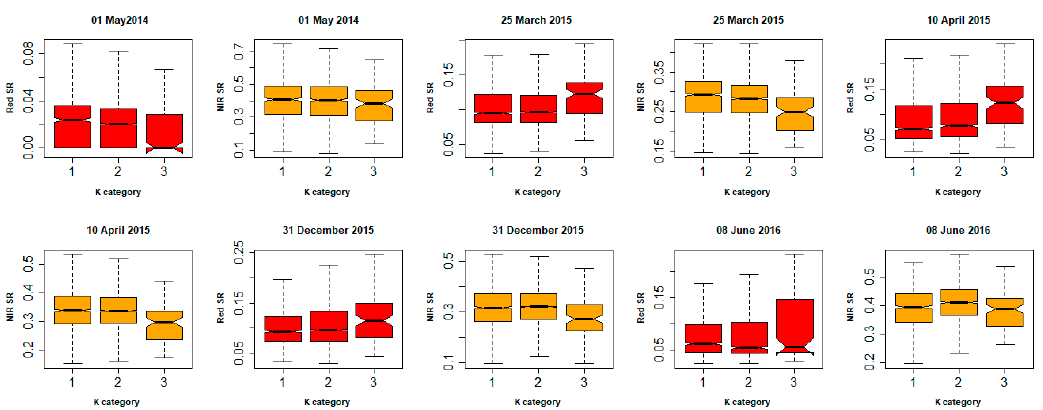
Figure 7. Comparison of surface reflectance (SR) values across soil erodibility (K) categories in different images (scene dates chosen based on statistically significant impact on C ndvi according to Table 4). K categories: 1, ≤ 0.15; 2, = 0.15 to 0.3; 3, ≥ 0.3. The notches in the boxes indicate statistical significance in median reflectance of Red and Near Infrared (NIR) along the K categories at a 95% confidence interval.